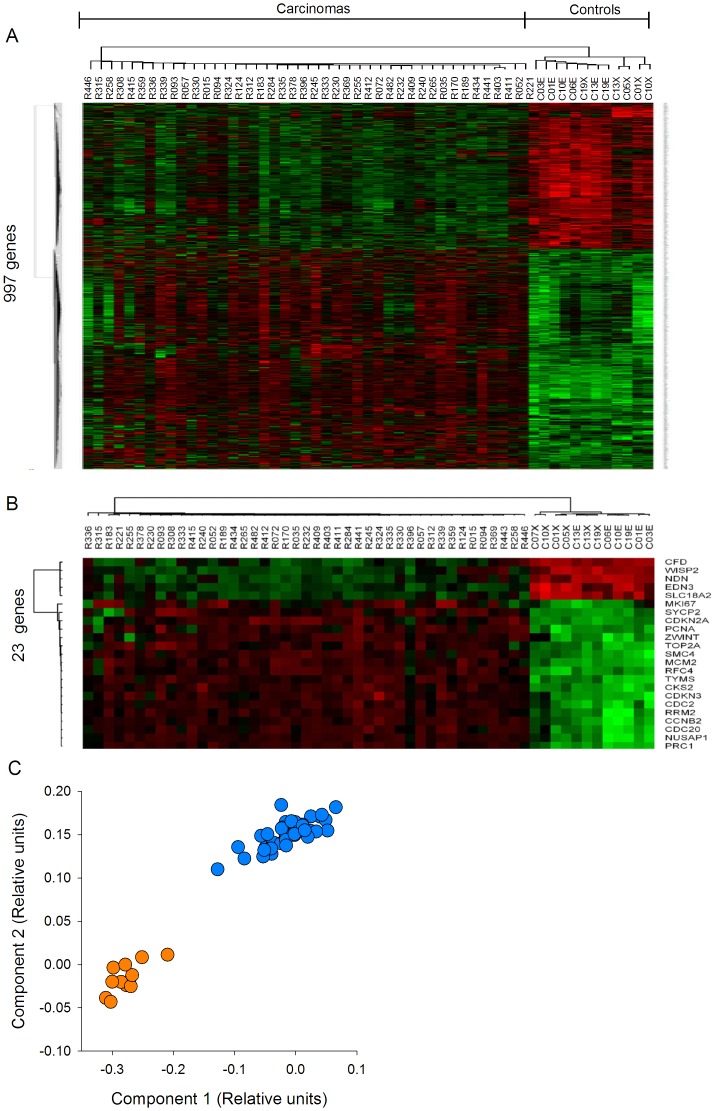
Segregation of tumor and control samples according to the expression of deregulated genes.Unsupervised hierarchical cluster analysis of 43 CCs and 12 healthy cervical epitheliums using the expression values obtained with the HG-Focus microarray of all 997 deregulated genes (panel A) or the 23 top ranked genes selected for validation (panel B). Each row represents a gene and each column represents a sample. The length and the subdivision of the branches represent the relationships among the samples based on the intensity of gene expression. The cluster is color-coded using red for upregulation, green for downregulation, and black for unchanged expression. Panel C shows the principal components analysis (PCA) using the values in panel B; blue circles represent the CCs (n = 43) and yellow circles represent the controls (n = 12). Both sets of genes clearly separated the samples into the 2 main groups using both types of analysis.